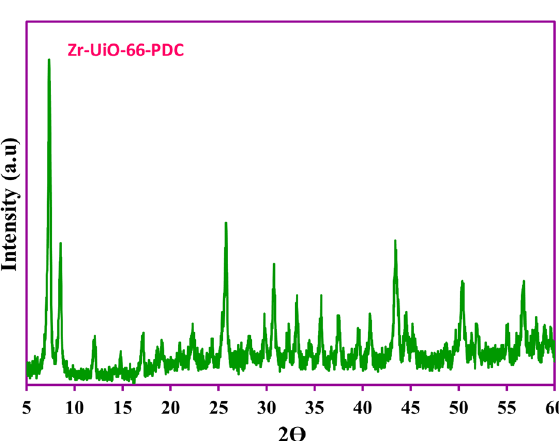
Figure 4. PXRD spectrum of the Zr-UiO-66-PDC MOF sample.